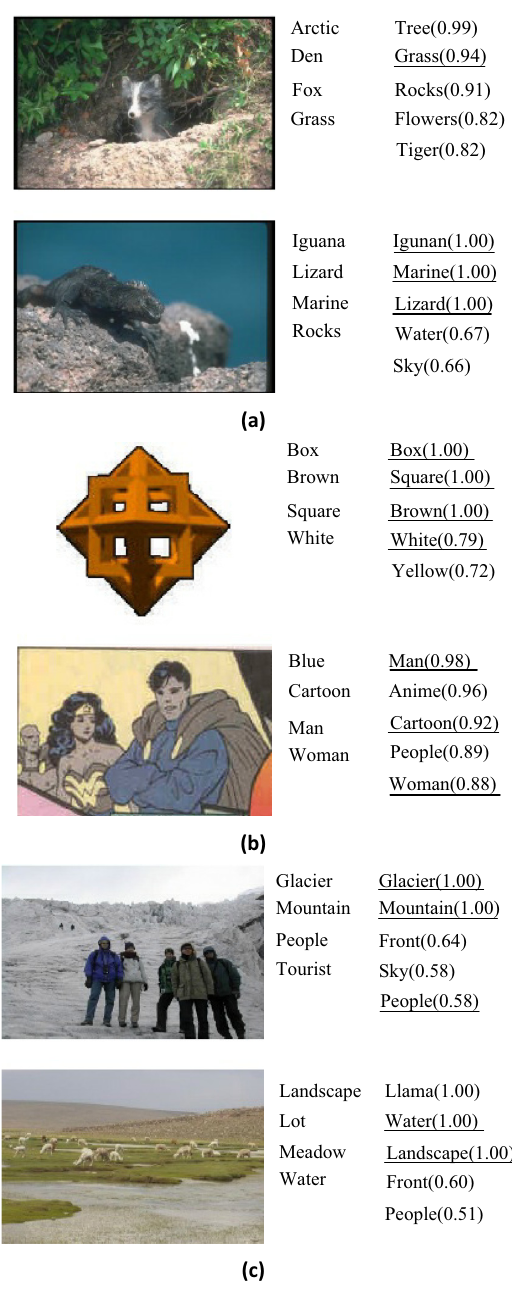
Figure 1: Example test images from the three data sets: ( a ) Corel 5k, ( b ) ESP Game, and ( c ) IAPR